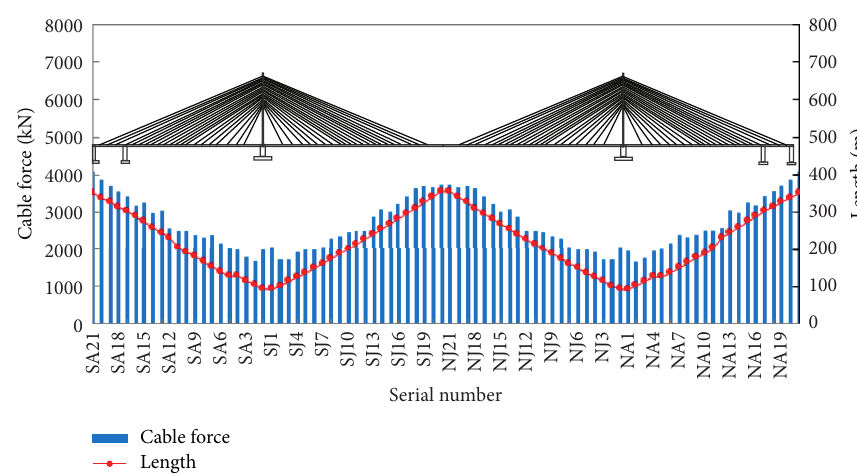
Figure 7: The designed cable forces and cable length of completed